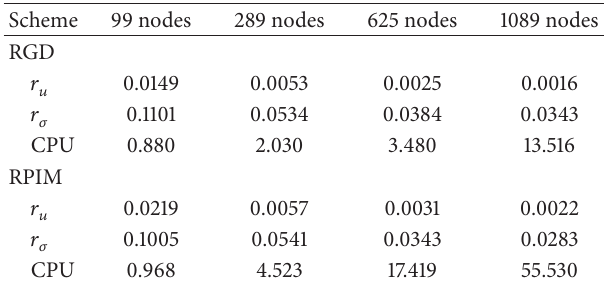
Table 8: Effect of the size of support domain for the RG methods for the 99 nodes (Example 5.3 ).